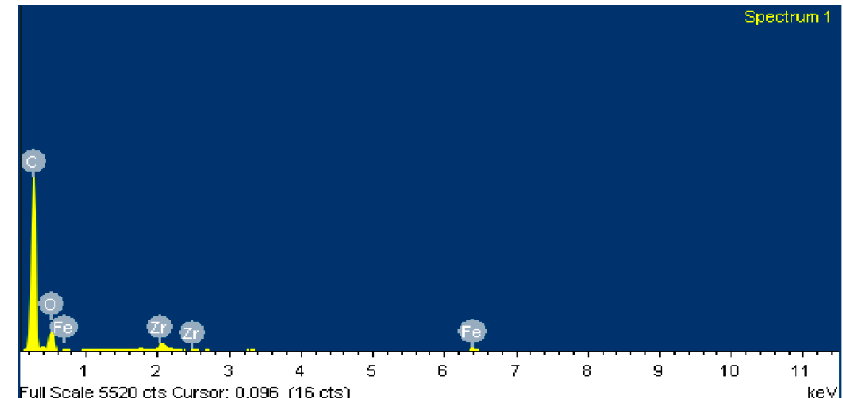
Figure 13. SEM image for zone 1 in the PA46Z sample.